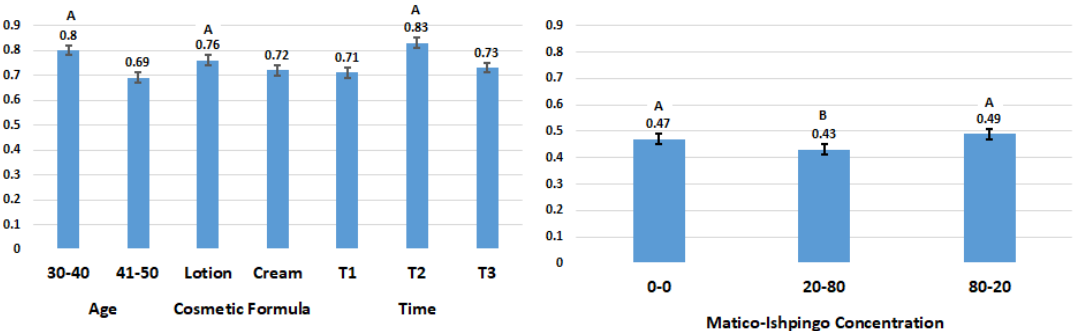
Figure 2. Adjusted means of R5 factors R5 and R6. Note. Two treatments without a common letter are statistically significant ( p ≤ 0.05).